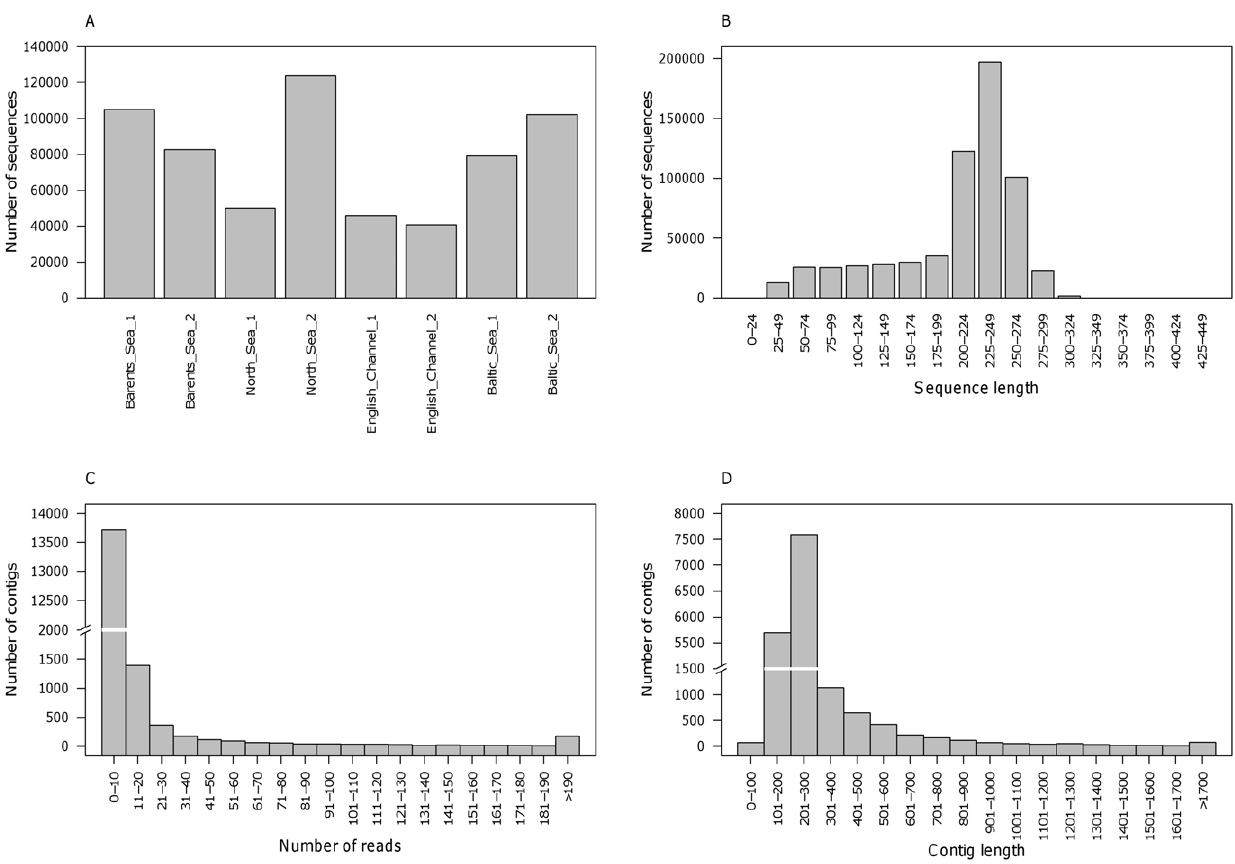
Figure 3. Summary of sequence data. A) number of sequences successfully barcoded for each of the eight ascertainment individuals; and for the combined data, B) sequence length, C) number of reads per contig and D) contig length.